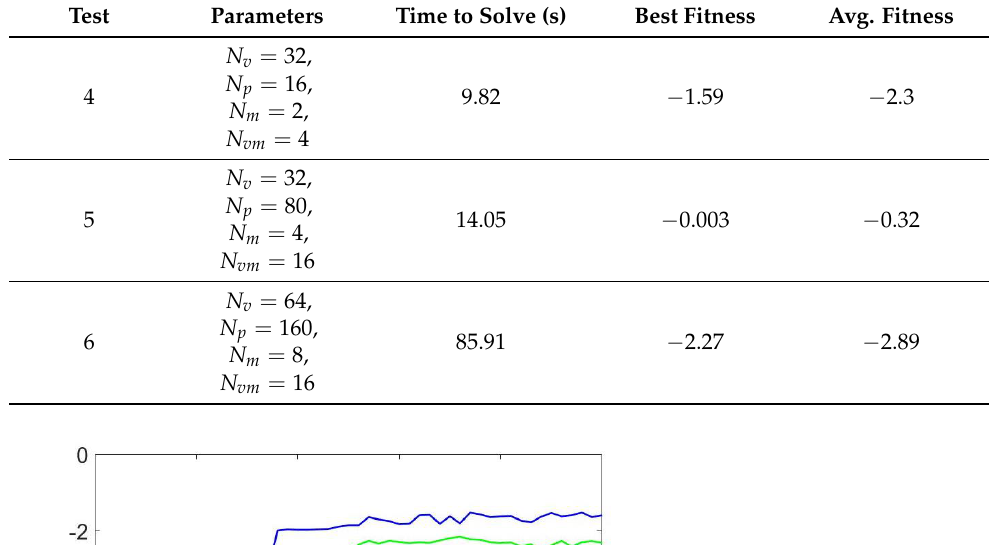
Table 3. Experiment 2. GP algorithm using objective function with penalties for suboptimal NUMA mappings.